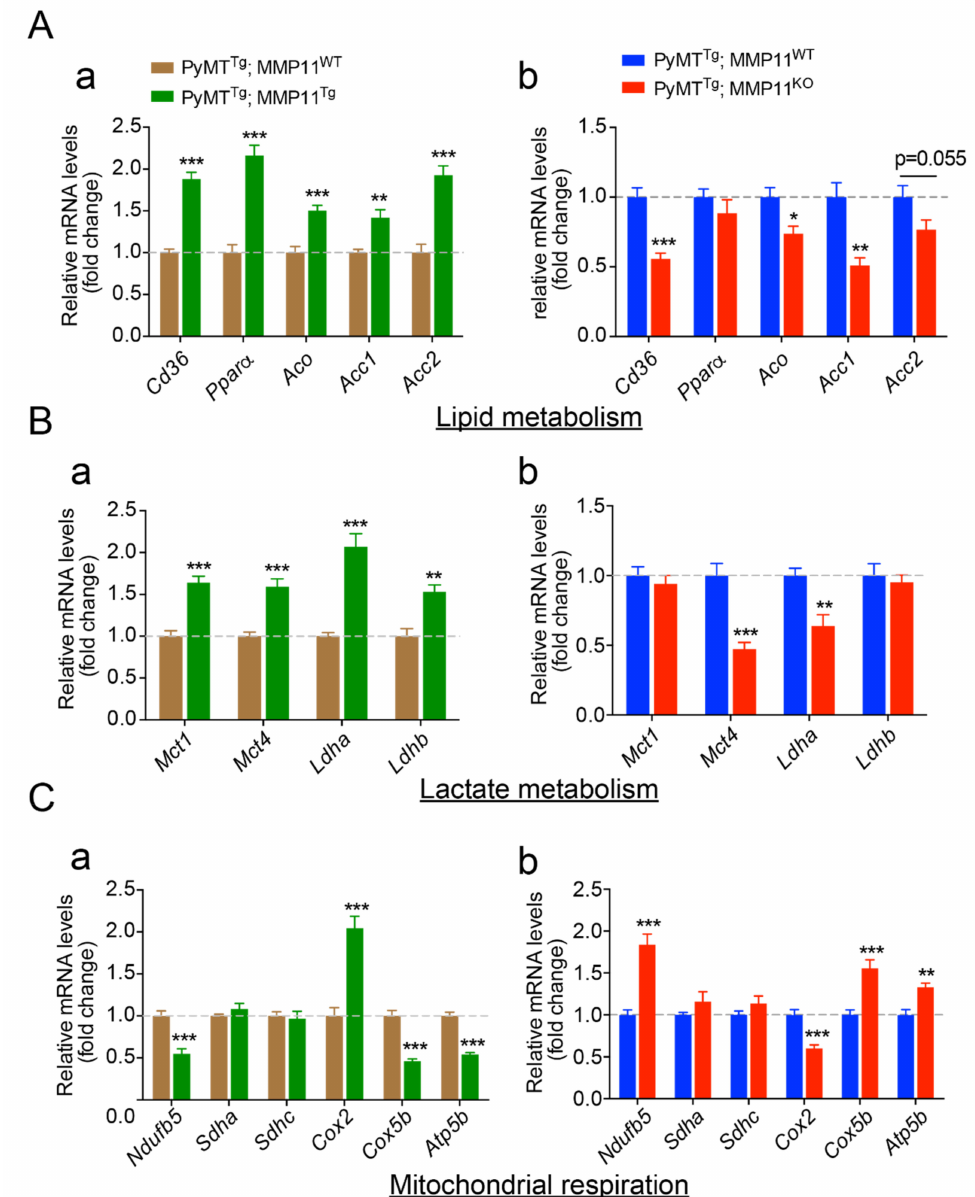
Figure 4. MMP11 promotes mammary gland tumor metabolic switch and lipid utilization. RT-qPCR transcripts of genes involved in ( A ) lipid metabolism, ( B ) lactate metabolism, and ( C ) mitochondrial respiration in tumor extracts from both gain-of-function (GOF) (PyMT Tg ; MMP11 Tg , ( a ) left panels) mice and loss-of-function (LOF) (PyMT Tg ; MMP11 KO , ( b ) right panels) mice models. Data are presented as fold changes to control. N = 6–8 mice / group, data are presented as mean ± SEM, * p < 0.05, ** p < 0.01, *** p < 0.001 (unpaired t